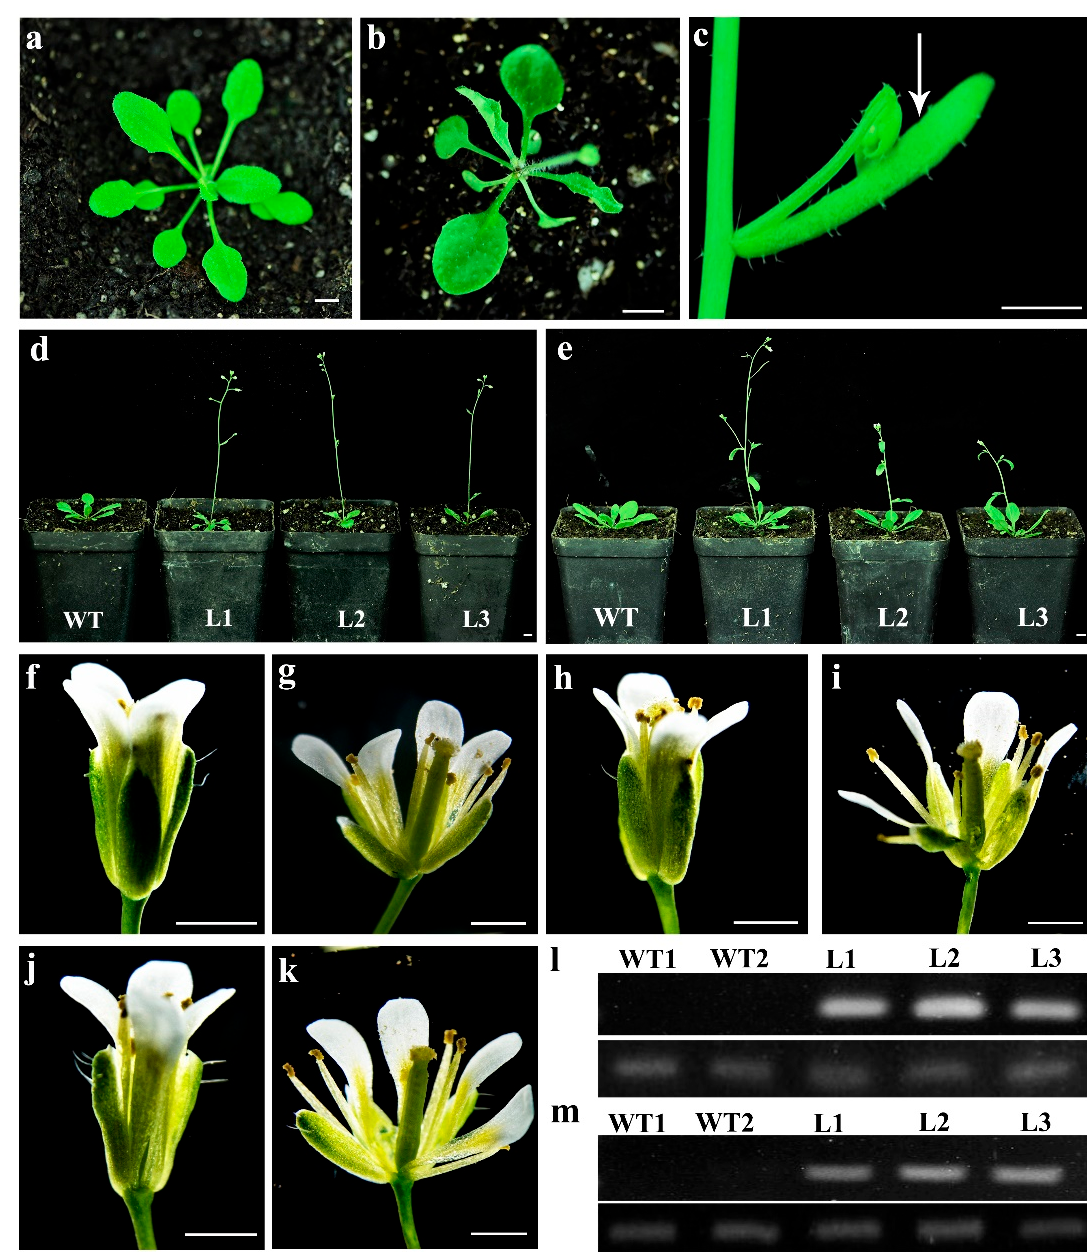
Figure 4. Abnormal morphology of transgenic Arabidopsis plants of constitutively expressed TeAP1-2 and TeFUL2 genes. ( a ) The wild-type seedling. ( b ) The transgenic seedlings with severely curled rosette leave in 35S:TeAP1-2 transgenic lines. ( c ) The curled cauline leaves of 35S:TeAP1-2 transgenic lines. ( d ) Wild-type (left) and early flowering transgenic plant (right) of 35S:TeAP1-2 transgenic lines; WT: wild-type line 1; L1: 35S:TeAP1-2 line 1; L2: 35S:TeAP1-2 line 2; L3: 35S:TeAP1-2 line 3. ( e ) Wild-type (left) and early flowering transgenic plant (right) of 35S:TeFUL2 transgenic lines; WT: wild-type line 1; L1: 35S:TeFUL2 line 1; L2: 35S:TeFUL2 line 2; L3: 5S:TeFUL2 line 3. ( f ) The flower of wild-type Arabidopsis plants. ( g ) The anatomy of wild-type Arabidopsis flower. ( h ) The flower of 35S:TeAP1-2 transgenic plants. ( i ) The anatomy of 35S:TeAP1-2 transgenic plant flowers. ( j ) The flower of 35S:TeFUL2 transgenic plants. ( k ) The anatomy of 35S:TeFUL2 transgenic plant flowers. ( a – e ), bar = 5 mm; ( f – k ), bar = 500 μ m. ( l ) Expression of TeAP1-2 in seedlings of T 1 transgenic plants by semi-RT-PCR. The picture above is the expression level of TeAP1-2 in transgenic lines, the band size was 106 bp; the picture below the constitutive gene is the Arabidopsis keeping-house gene AtEF1 α . ( m ) Expression of TeFUL2 in seedlings of T 1 transgenic plants by semi-RT-PCR. The picture above is the expression level of TeFUL2 in transgenic lines, the band size was 127 bp; the picture below the constitutive gene is Arabidopsis house-keeping gene AtEF1 α .